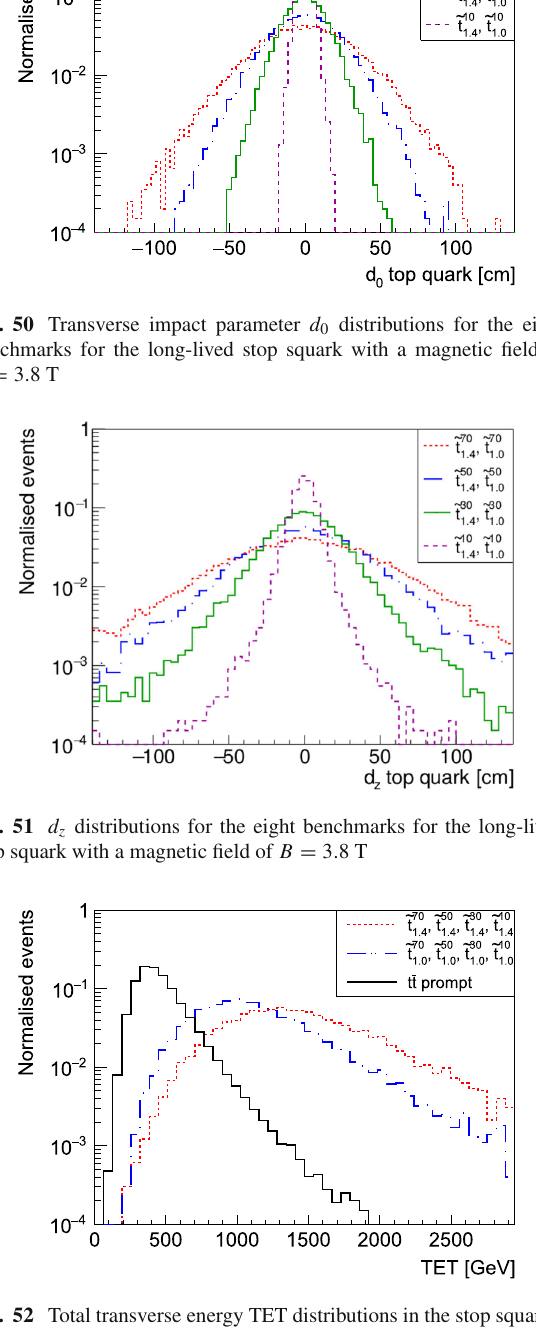
Fig. 52 Total transverse energy TET distributions in the stop squark ˜ t case From the large mean values of the transverse momen- tum of the hardest jet (cid:3) p T ( j 1 ) (cid:4) in Table 6, we may iden-